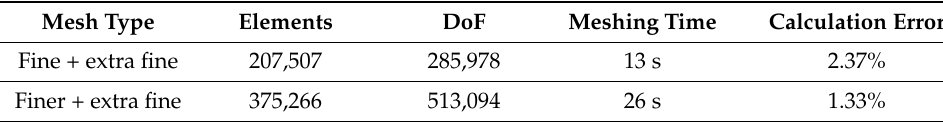
Table 3. Mesh statistics of user-controlled